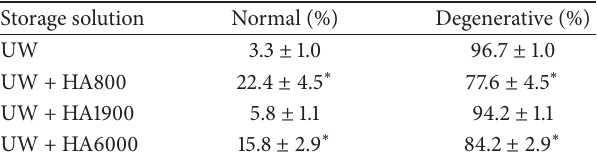
Table 2: Proportion of normal and degenerative chondrocytes in OCT samples cold preserved in hyaluronic acid- (HA-) supple- mented UW solution.